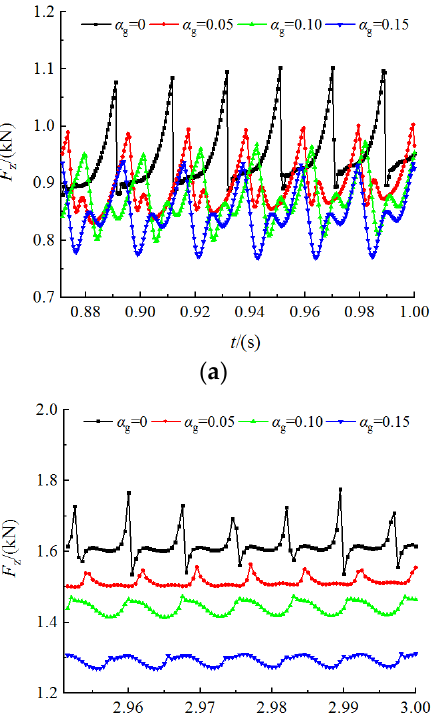
( d ) Figure 13. Frequency domain characteristic of radial force pulsation during the start-up process. ( a ) t = 1 s; ( b ) t = 2 s; ( c ) t = 3 s; ( d ) t = 4 s. 3.4. Axial Force Analysis Due to the asymmetry between the front and the back shroud of the impeller and the difference in compression area, the axial force acting on the PAT impeller is produced in its start-up process. The axial force is mainly composed of the internal force acting on the front and the back shroud of the impeller, the external force acting on them, and the force acting on the blade [14]. The start-up process has been respectively calculated under four conditions of α g = 0, α g = 0.05, α g = 0.10, and α g = 0.15. The time domain characteristic of axial force during the start-up process is shown in Figure 14. At t = 1 s, the axial force shows the maximum amplitude and fluctuates twice in a fluctuation cycle under gas – liq- uid two-phase conditions. The magnitude and amplitude of the axial force under pure water conditions are greater than those under gas – liquid two-phase conditions. At t = 2 s, the axial force at α g = 0 and α g = 0.05 has a secondary fluctuation in a fluctuation period,